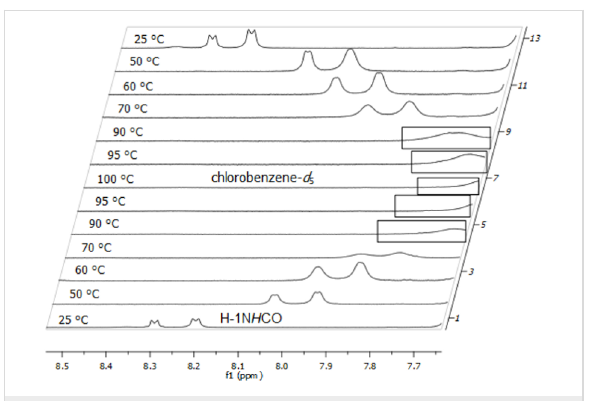
Figure 10: Temperature-dependent 1 H NMR (600 MHz) spectra of building block 1b in chlorobenzene- d 5 , broadened signals near the co- alescence temperature are marked.